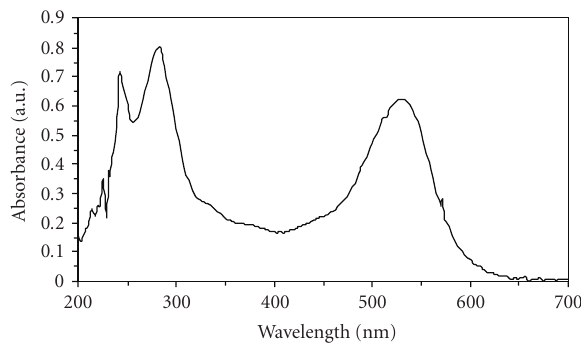
Figure 7: Absorbance spectra of black rice dyes